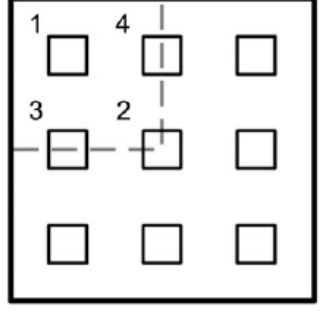
Figure 7. Nine core-tubes panel layouts [2].